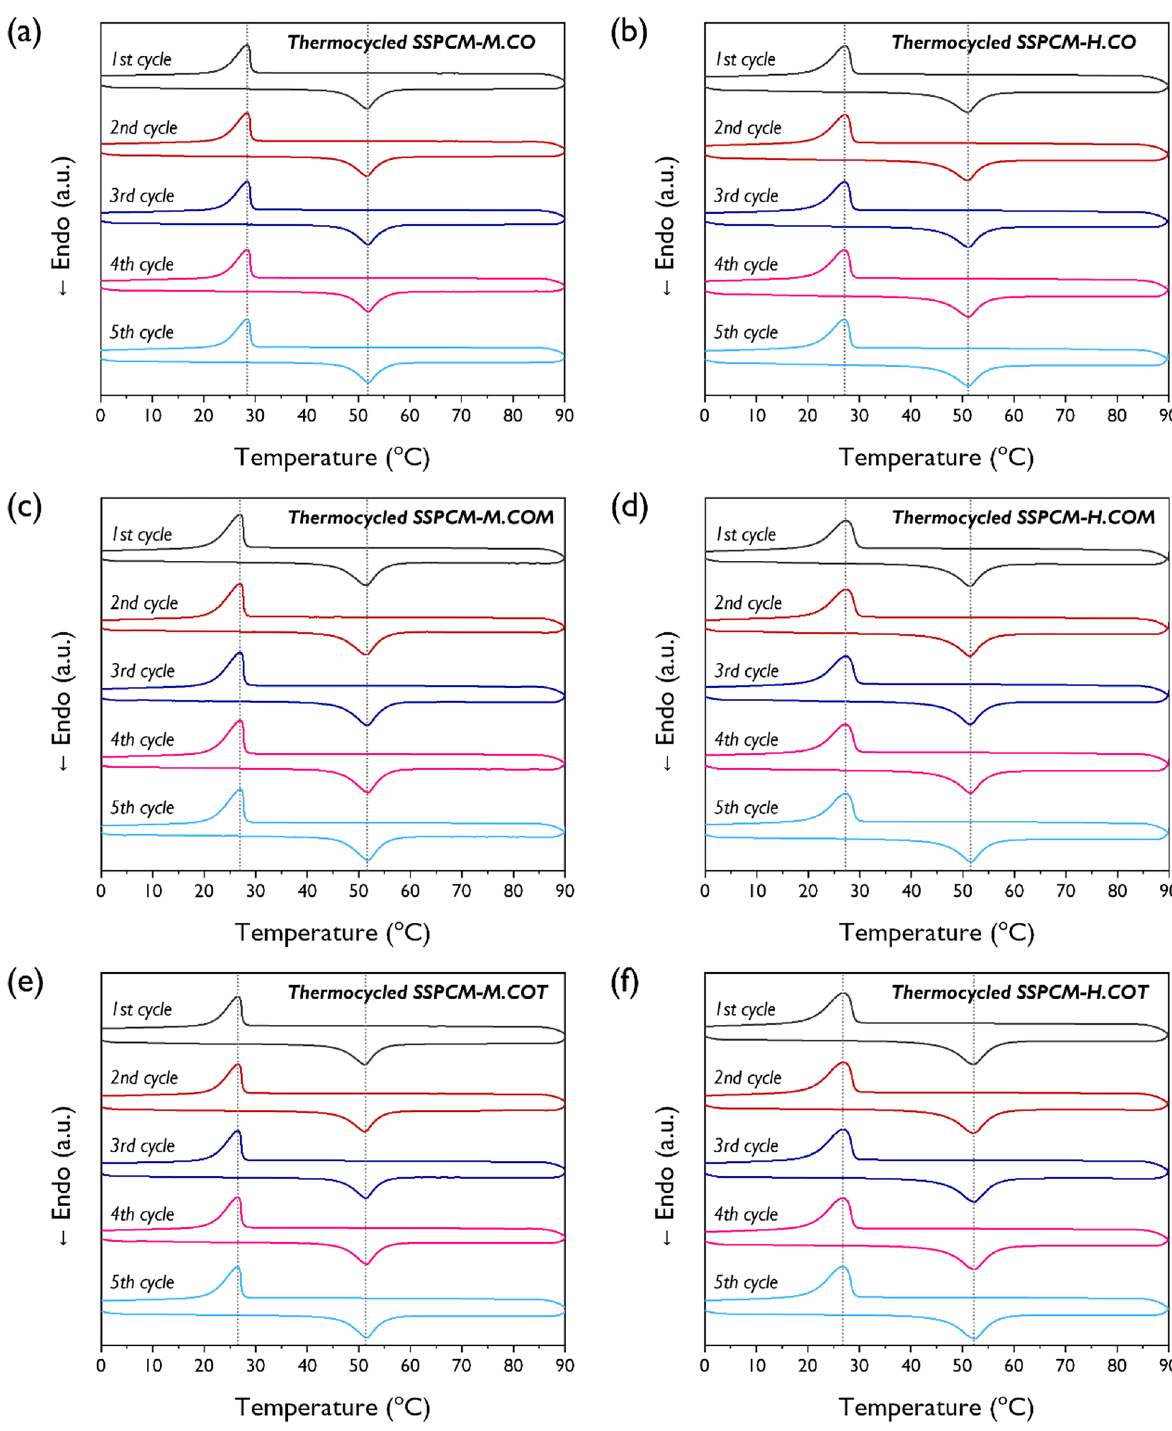
Figure 8. DSC curves of the SSPCMs with 5 consecutive heating–cooling cycles after the accelerated thermal cycling test; ( a ) M.CO, ( b ) M.COM, ( c ) M.COT, ( d ) H.CO, ( e ) H.COM, and ( f )